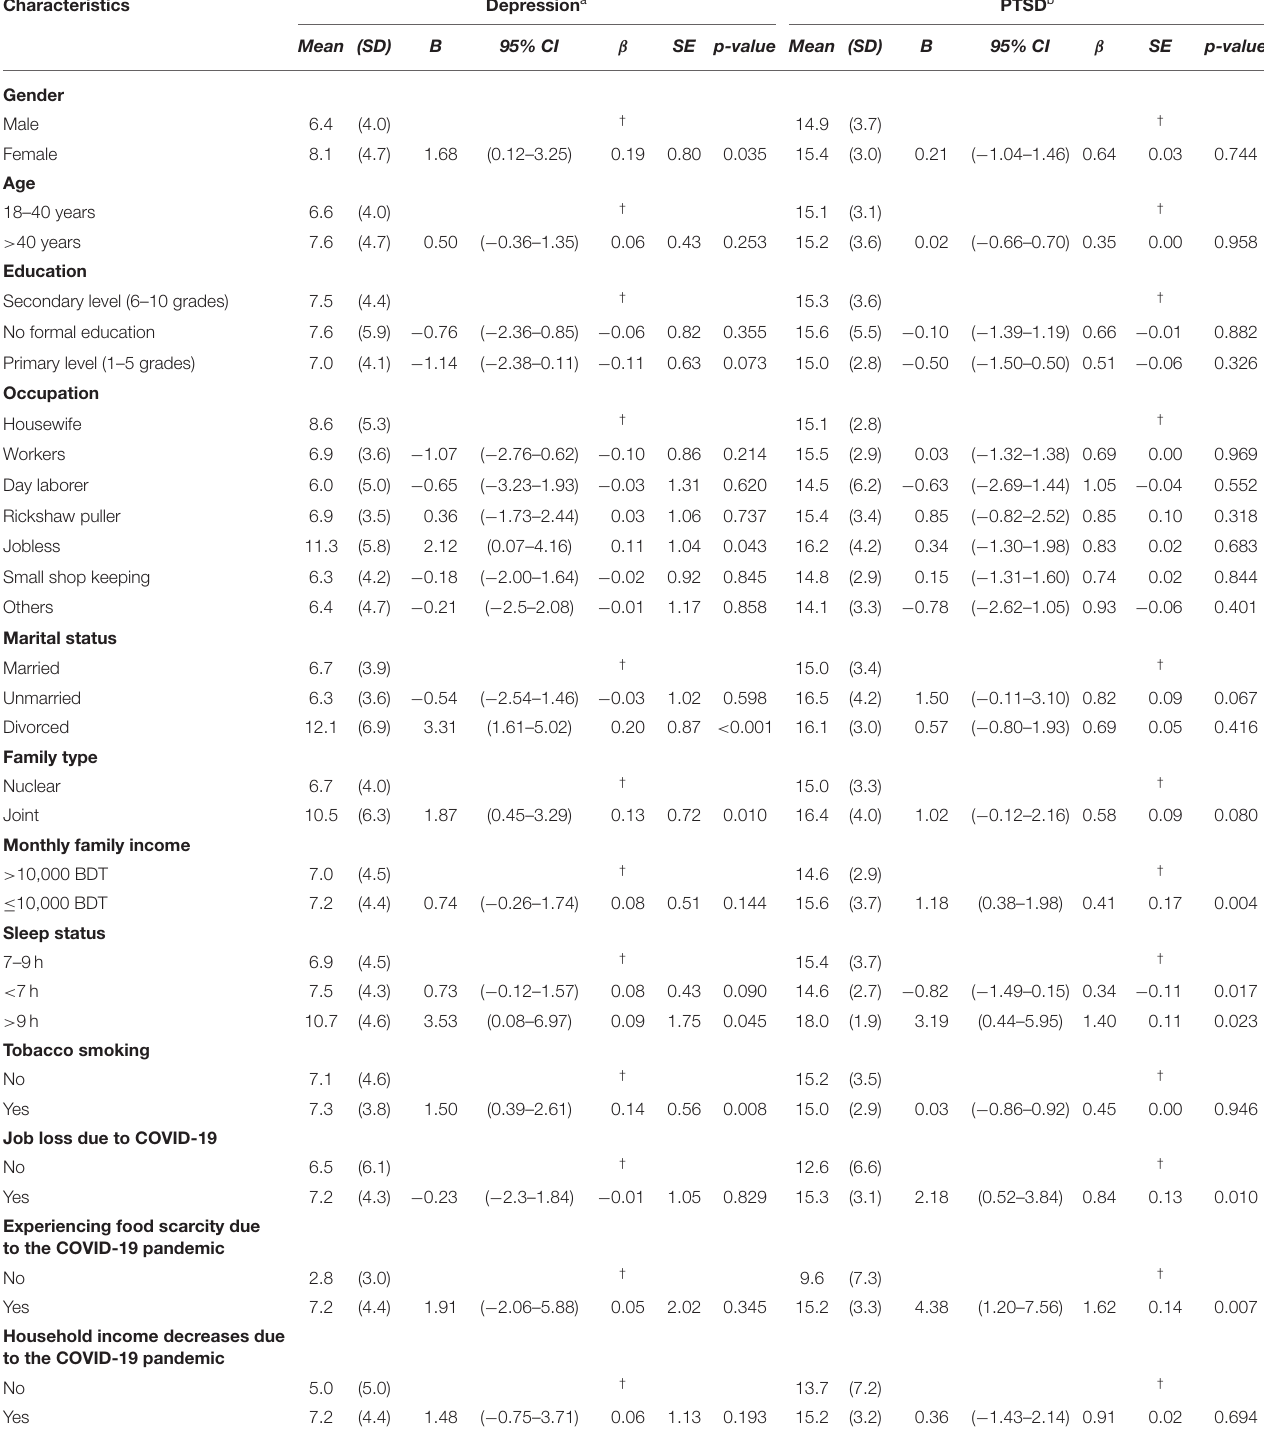
TABLE 2 | Multiple regression analysis predicting depression and PTSD.